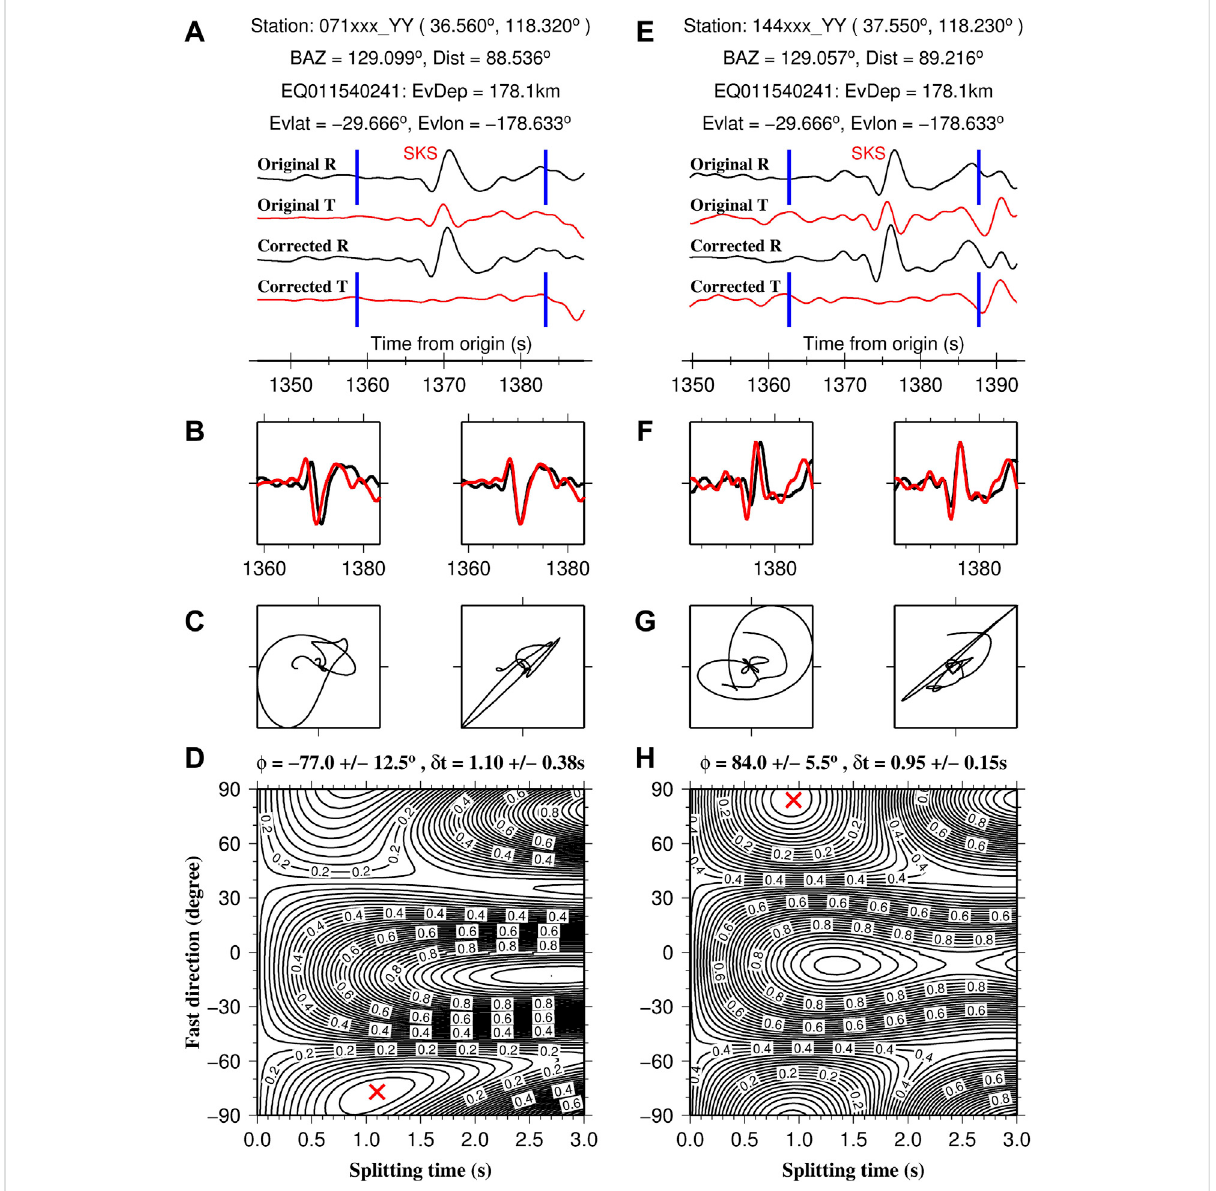
FIGURE 3 Two examples of the SKS splitting analyses at Stations 071 (A – D) and 144 (E – H) as shown in Figure 1. (A,E) Original and corrected radial (R) and transverse(T)SKSseismograms. (B,F) Original(left)andcorrected(right)fast(red)andslow(black)waves. (C,G) Original(left)andcorrected(right)SKS particle motion patterns. (D,H) Contour plots of transverse energy. The red cross represents the optimal splitting